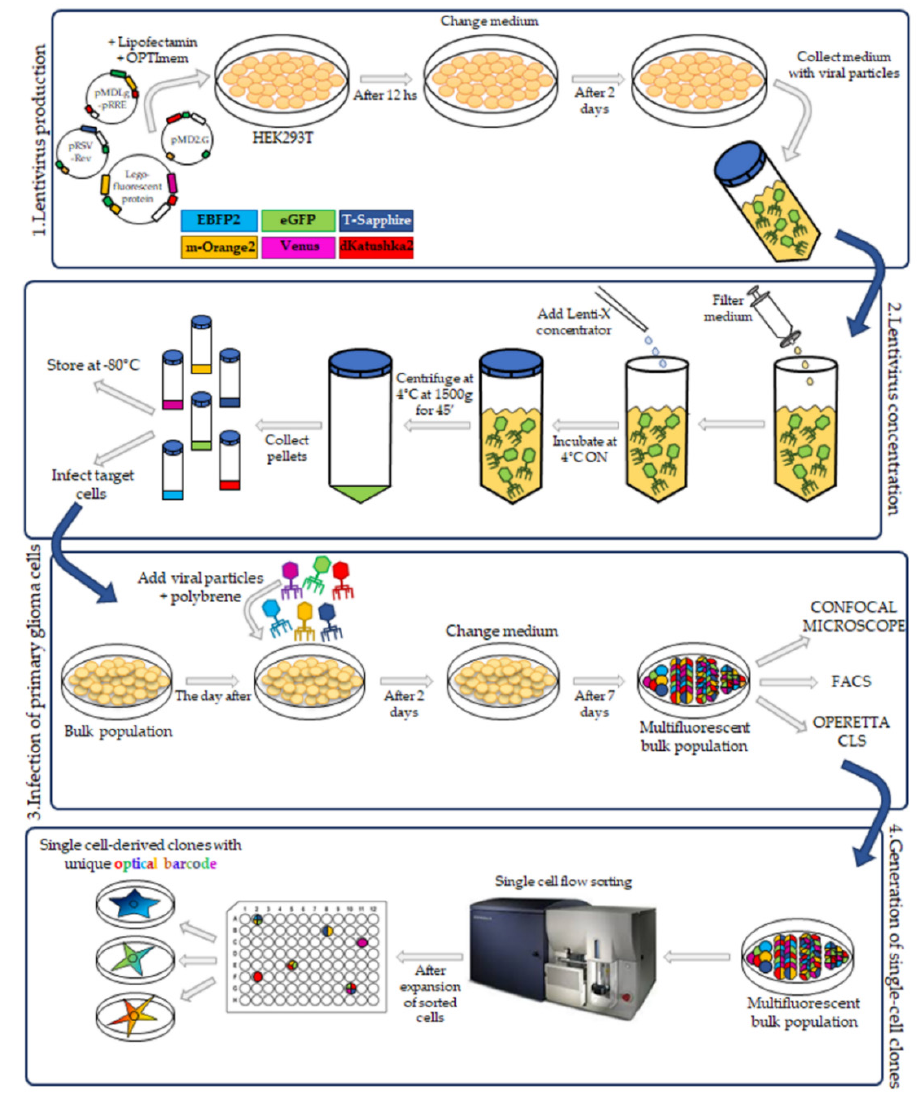
Figure 1. Workflow— pediatric glioblastoma (pGBM) and di ff use intrinsic pontine glioma (DIPG) cell transduction for the generation of multifluorescent bulk cell lines and optical barcoded single cell-derived clones. Schematic workflow from the lentivirus production of six di ff erent lentiviral gene ontology (LeGO) vectors for the Multifluorescent Marking Technology. Lentivirus vectors were produced thanks to the transient transfection of HEK-293T cells. The medium was collected, and the viral particles were concentrated and subsequently used for the pGBM and DIPG primary cell lines infection to generate the multifluorescent bulk primary cell lines. The primary multifluorescent bulk population was single cell-flow sorted into 96-well plates to grow and establish single cell-derived clones characterized by specific optical barcodes. Multifluorescent bulk population and derived clones were characterized for their fluorescent make up by using di ff erent multimodal platforms: Flow Cytometer, Confocal microscope, and Operetta